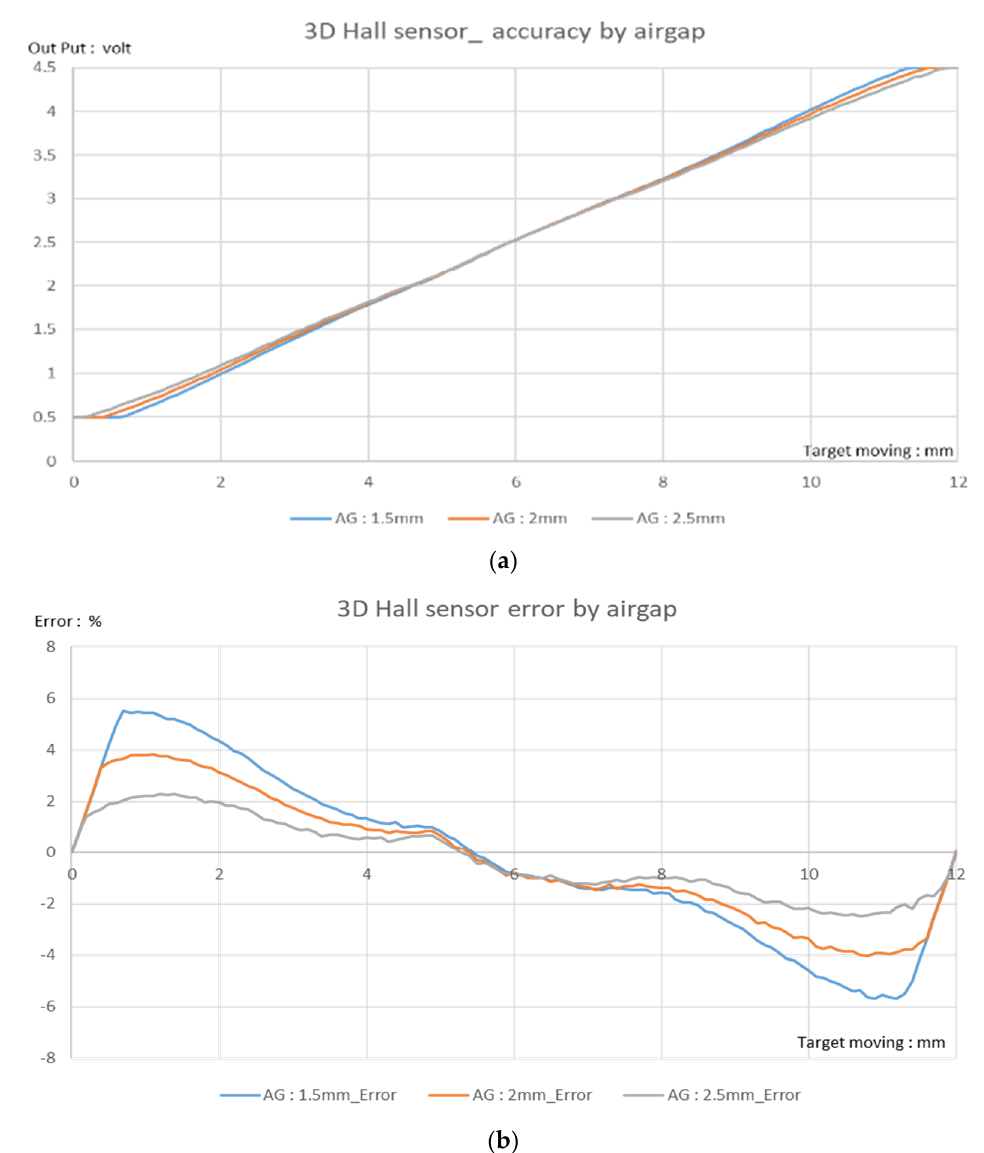
Figure 8. Results of 3D Hall sensor (MLX90333) 0–12 mm-stroke test for various airgaps (AG): ( a ) output vs. target position; ( b ) corresponding error. The accuracy requirement of ±1% was not met.